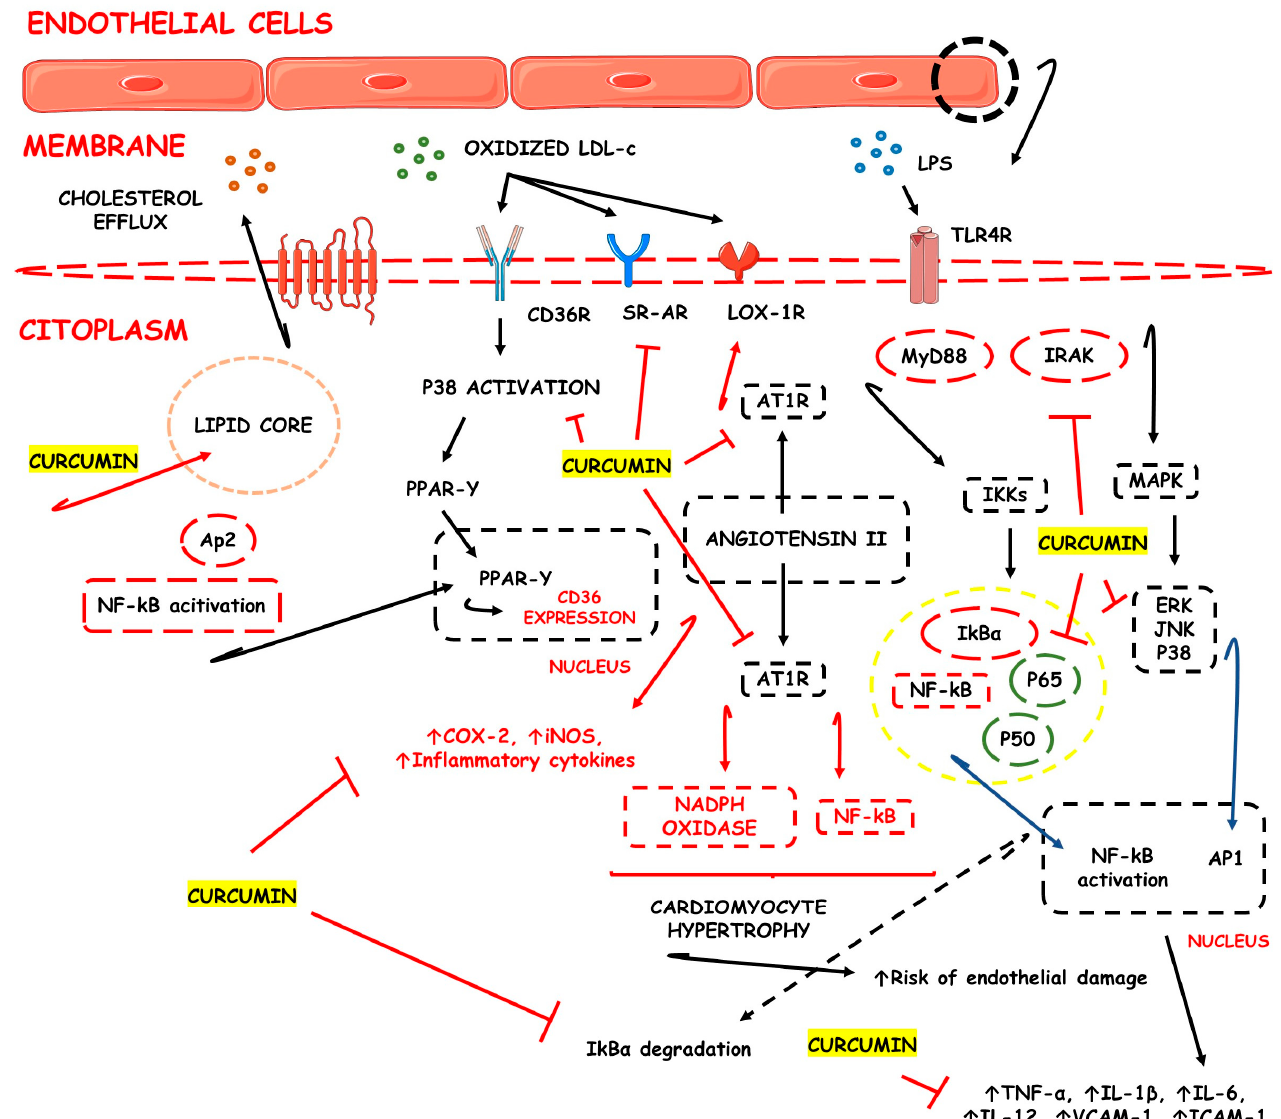
Figure 1. Possible mechanisms associated with CUR’s protective effects against atheroma formation. Atherosclerosis is a phenomenon that depends highly on modified LDL in the arterial vessels. CUR protects against atherosclerosis via anti-inflammatory and immunomodulating effects, as well as exerting antilipidemic actions and promoting MMP expression down-regulation. ↑ , increase; Ap2, apetala type 2; AT1R; angiotensin 1 receptor; CD36R, CD36 receptor; COX-2, ciclooxigensase 2; ERK, extracellular signal-regulated kinases; ICAM-1, intercellular adhesion molecule 1; IkBa, nuclear factor of kappa light polypeptide gene enhancer in B-cells inhibitor alpha; IKKs, I κ B kinases; IL, interleukin; IRAK, interleukin-1 receptor-associated kinases; JNK, N-terminal kinase; iNOS, inducible nitric oxide synthase; LDL-c, low-density lipoprotein cholesterol; LOX-1R, lysyl oxidase type 1; LPS, lipopolysaccharides; MAPK, mitogen-activated protein kinase; MyD88, myeloid differentiation primary response 88; NF-kB, nuclear factor kappa b; P38, p38 signaling transduction pathway; P50, NF-kB P50 heterodimer; P65, NF-kB P65 heterodimer; PPAR γ , peroxisome proliferator-activated receptor γ ; SR-AR, scavenger receptor type A; TLR4, tool-like receptor 4; TNF- α , tumor factor necrosis alfa; VCAM-1, vascular cell adhesion molecule 1.